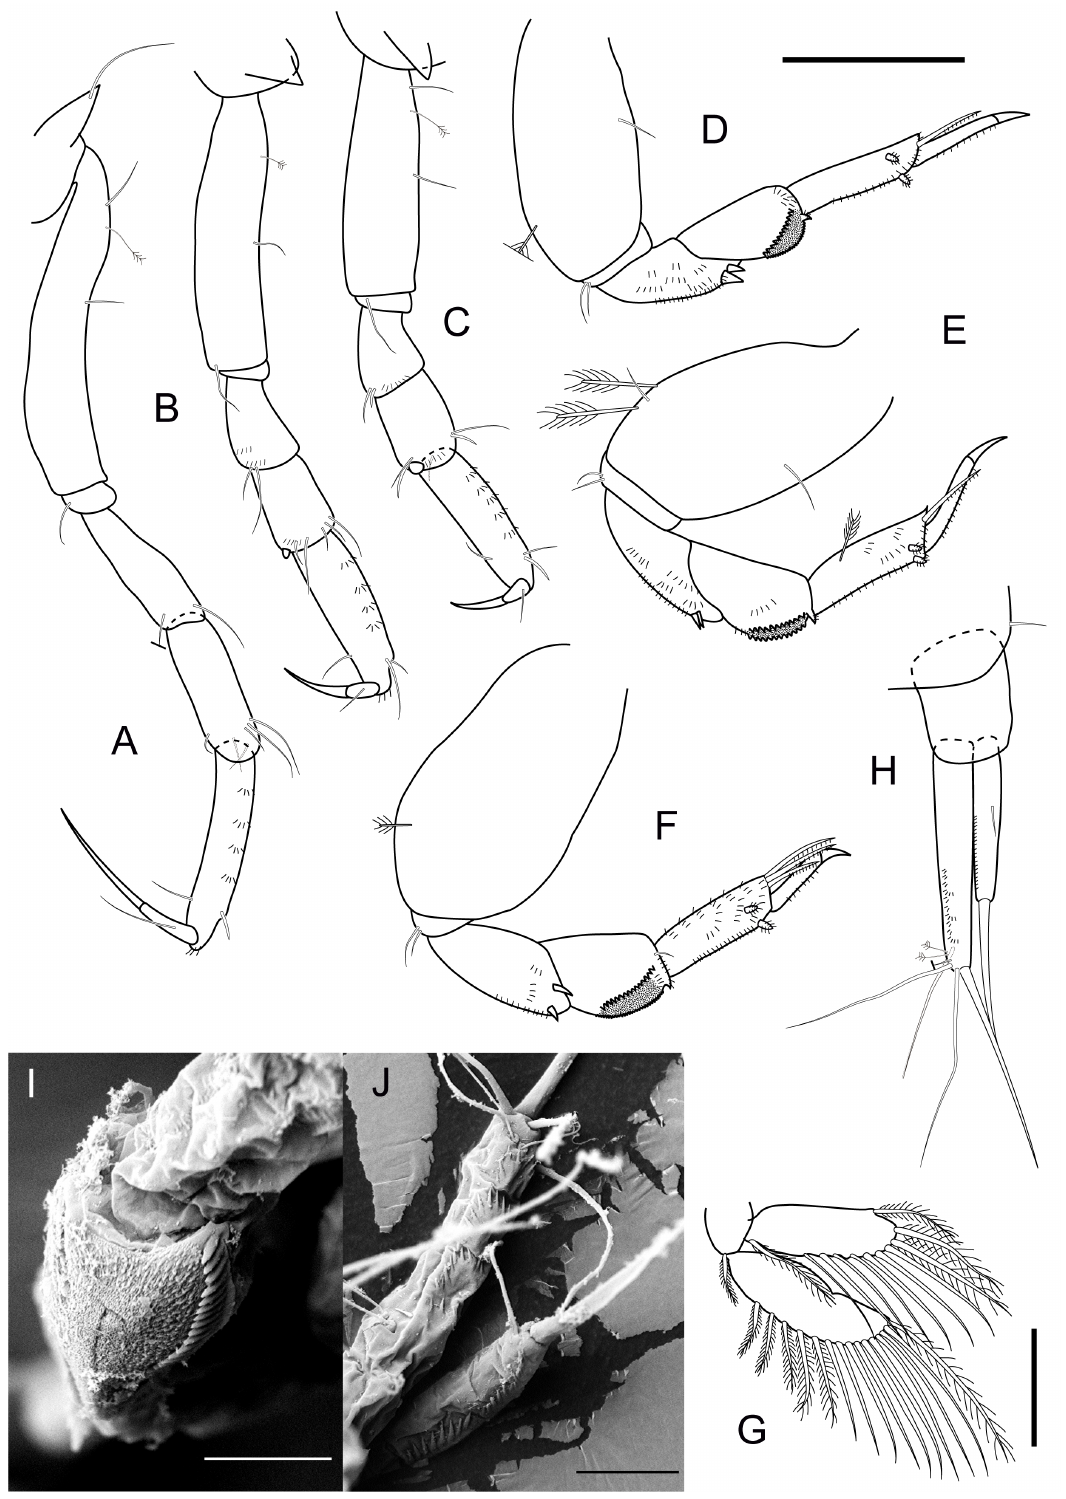
Fig. 13. Typhlotanais ischnochela sp. nov. A–H . Paratype (MZUSP 34428), ♀, dissected. A–F . Pereopods 1–6. G . Pleopod. H . Uropod. I–J . Additional material, ♀ (MZUSP 38014). I . Detail of pereopod prickly tubercles surrounded by spines. J . Detail of uropod microtrichia. Scale bars: A–H = 0.1 mm; I = 0.01 mm; J = 0.02